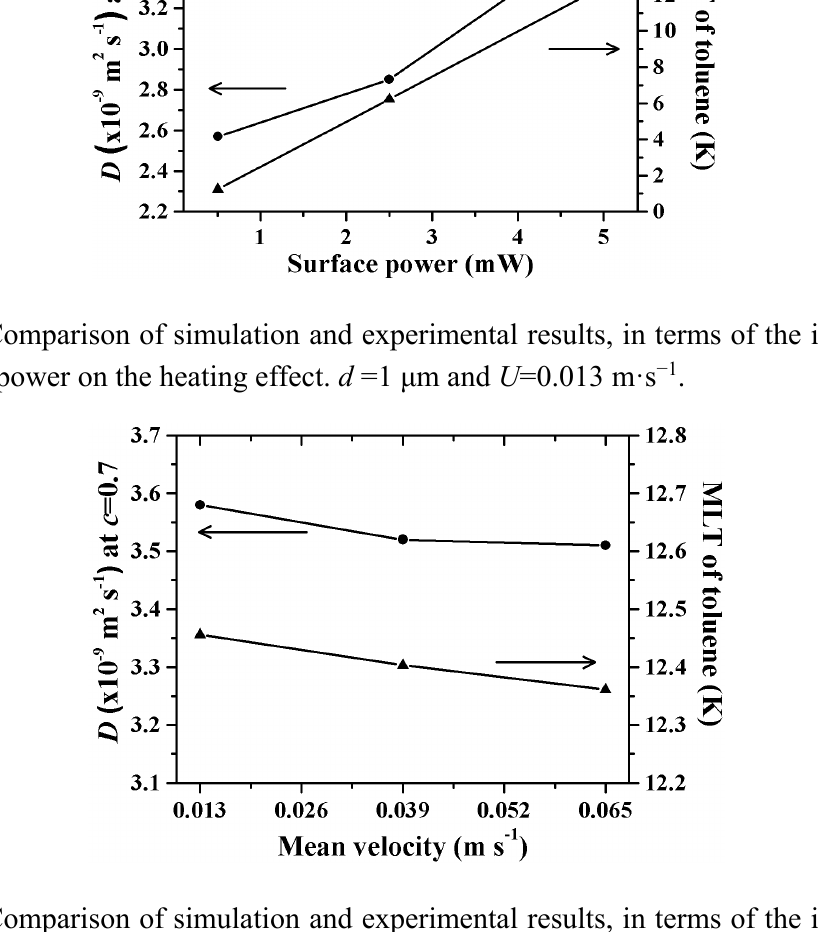
Figure 9. Comparison of simulation and experimental results, in terms of the influence of the mean velocity on the heating effect. P = 5 mW and d =1 μ